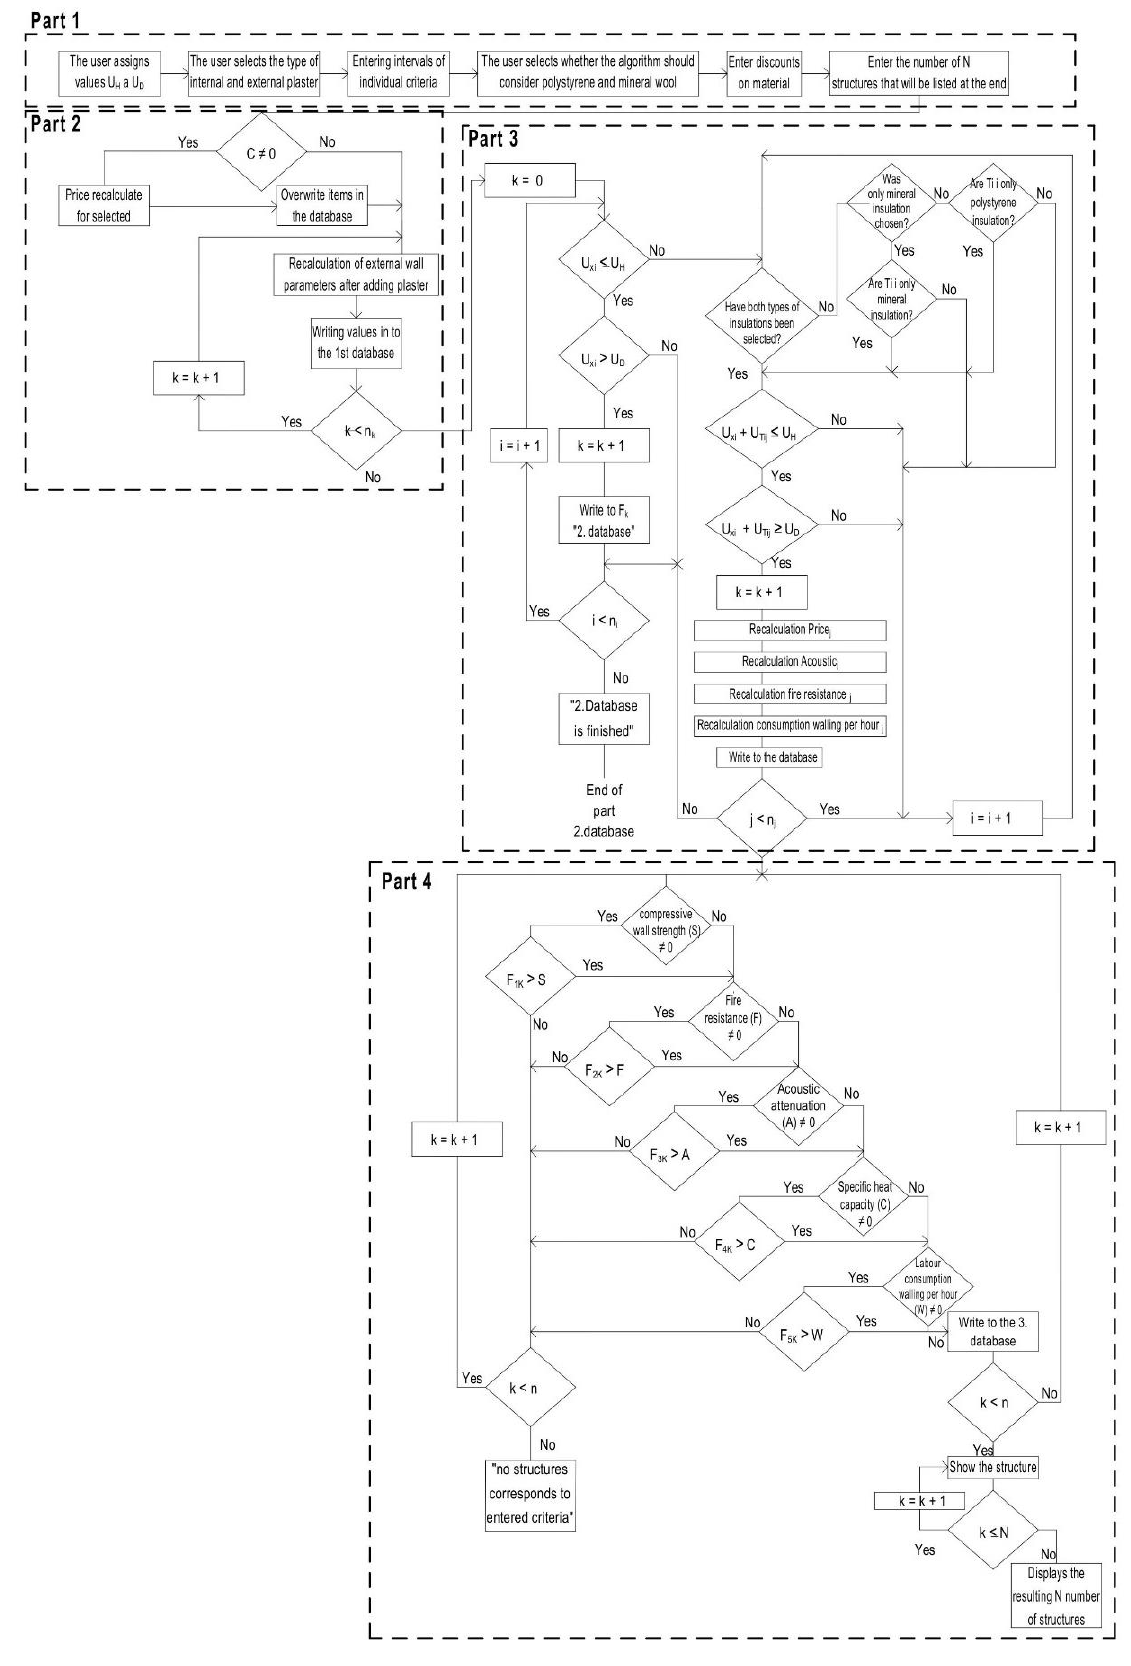
Figure 3. The whole process of the first method of searching structures by ČSN 730540-2. The input prices of the materials are recalculated after the assignment is complete. This step takes place only if the discount was specified in the assignment. Otherwise, this step is skipped. The part of the flowchart depicting this section is shown in Part 2. Part 2 also shows the creation of the first database containing only plaster–masonry–plaster structures.